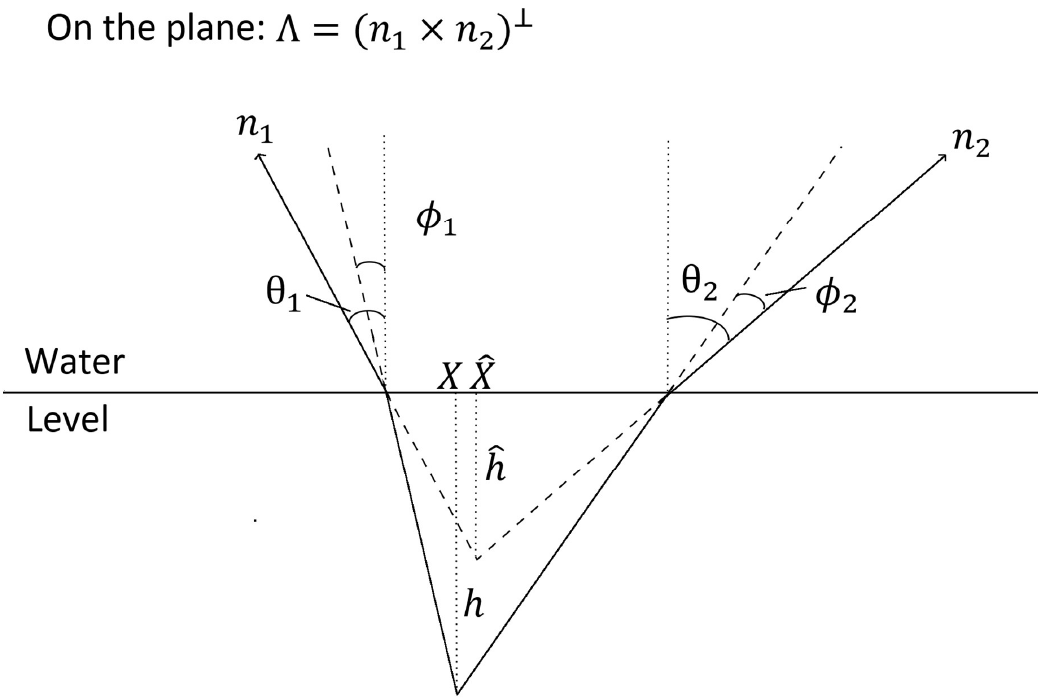
Figure 4. The geometry of the refraction